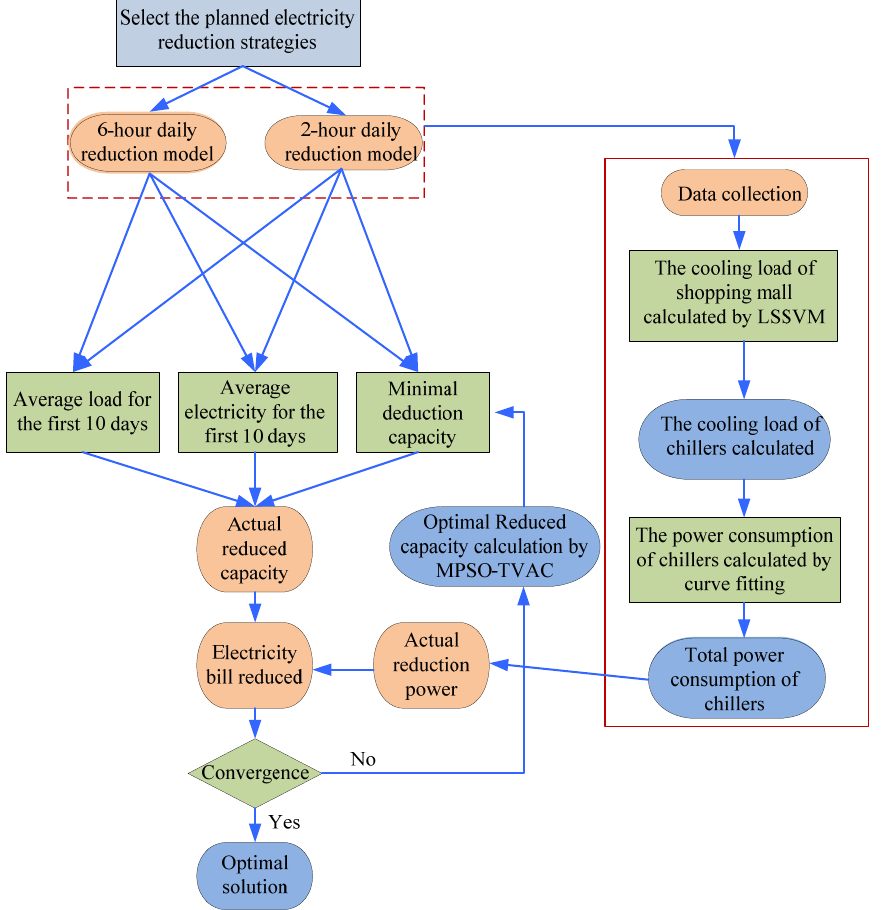
Figure 3. Flowchart of the solution algorithm.